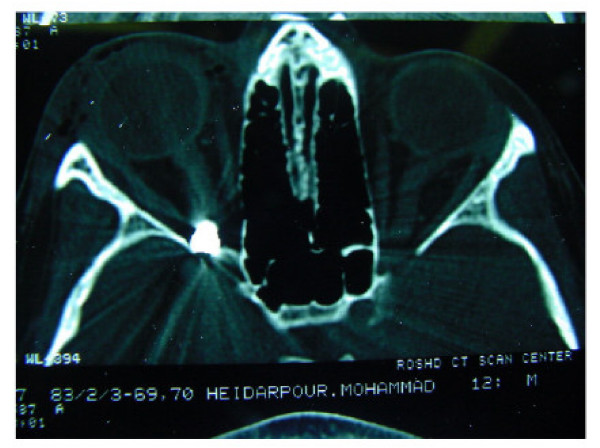
Axial orbital CT scan showing optic nerve transection at right orbital apex.